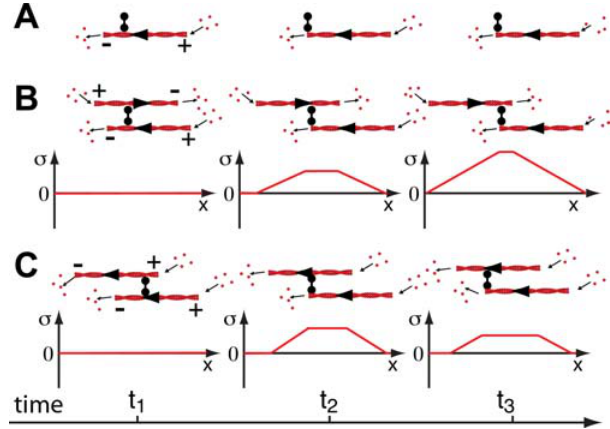
Figure 4. Stress generation in a bundle of treadmilling filaments and passive cross-linkers in the absence of motor proteins. (A) Three stages of the treadmiling of a pair of anti-parallel filaments. The arrows at the filament ends indicate that monomers are added at the plus ends and removed from the minus ends. As a consequence of treadmilling, in the absence of cross-linkers, the centers of mass of the filaments move relative to each other. At the same time, fixed subunits along the filaments do not move. Stresses can be generated if filaments are linked by passive cross-linkers, which have the ability to bind to filaments and also stay attached to depolymerizing filament ends (end-tracking cross- linkers). No stress is generated if monomers are cross-linked along filaments since these monomers do not move (left). As soon as one depolymerizing filament end is linked to the second filament by a cross- linker (middle), both filaments are physically moved relative to each other by depolymerization forces. This leads to a stress profile along the filament pair with positive (contractile) stress (middle and right). This process therefore contributes to contractile average bundle stress if many filament pairs are interacting in a filament bundle. Note that this is different from stress generation by motors, where anti-parallel filaments do not contribute to stress. (B) Stress profiles for a pair of treadmiling filaments that are arranged in parallel. Again, if a depoly- merizing end of one filament is linked to the second filament, relative sliding occurs which is driven by filament depolymerization. The resulting stress is positive